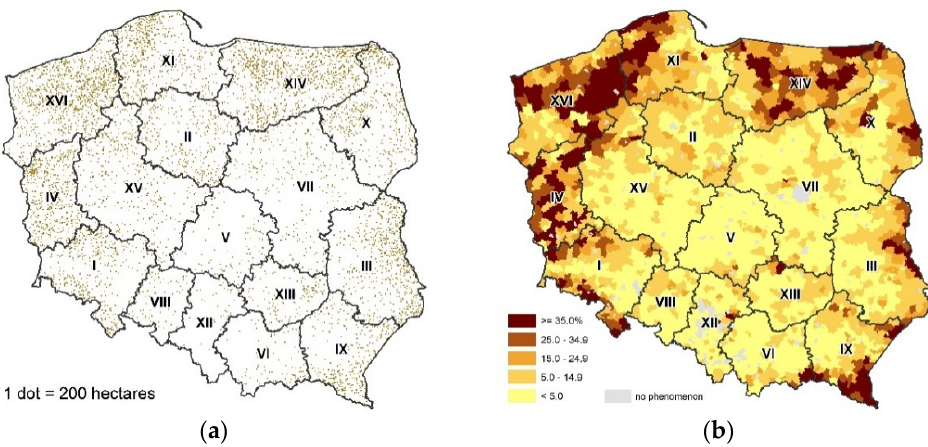
Figure 2. Area of land covered by pro-environmental RDP support ( a ), and its share in total UAA of farms ( b ).Source: own elaboration.